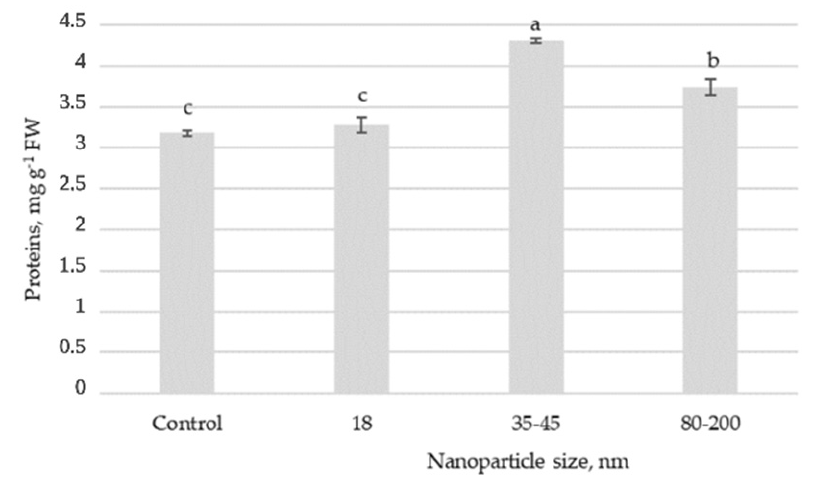
Figure 3. Particle size-dependent effects of ZnO nanoparticles on total soluble proteins of Swiss chard. Different letters represent significant differences. The data were processed using analysis of variance (ANOVA) and the Tukey (HSD) multiple range test at the confidence level of p = 0.05.